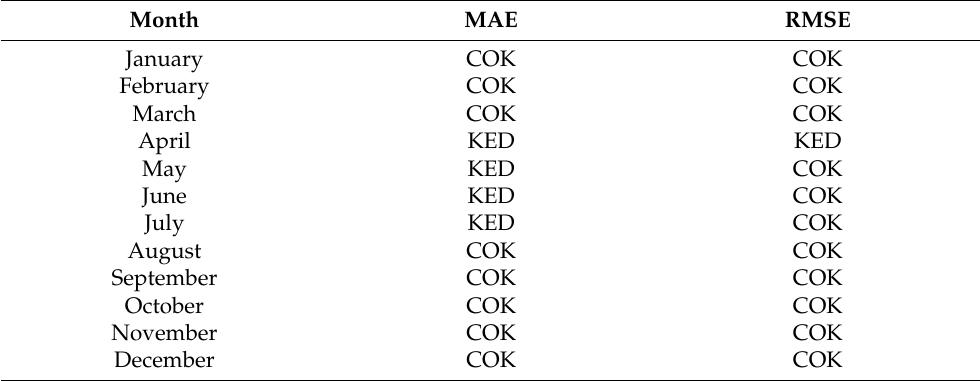
Table 3. Best interpolation method (inverse distance weighting, IDW; ordinary kriging, OK; kriging with an external drift, KED; ordinary cokriging, COK) based on the cross-validation test (mean absolute error, MAE; root-mean-square error,